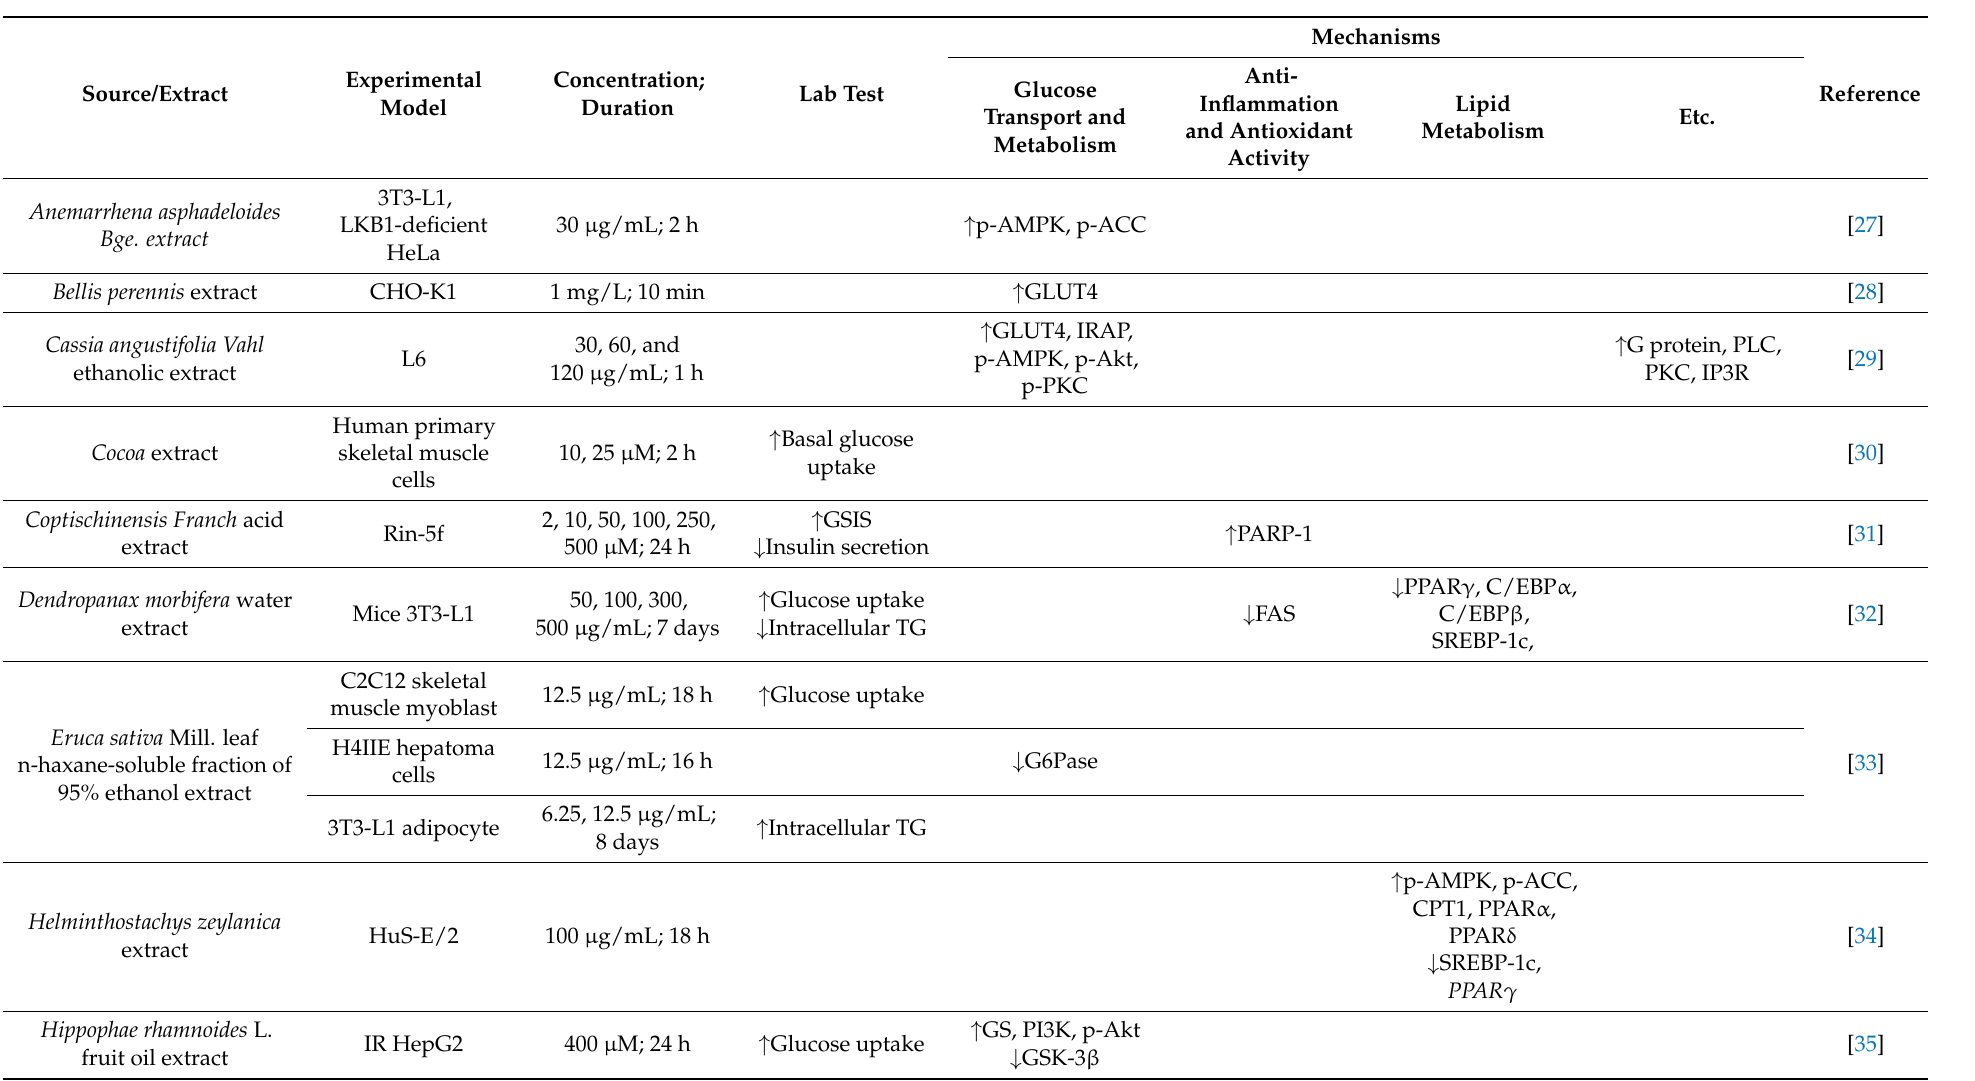
Table 1. In vitro